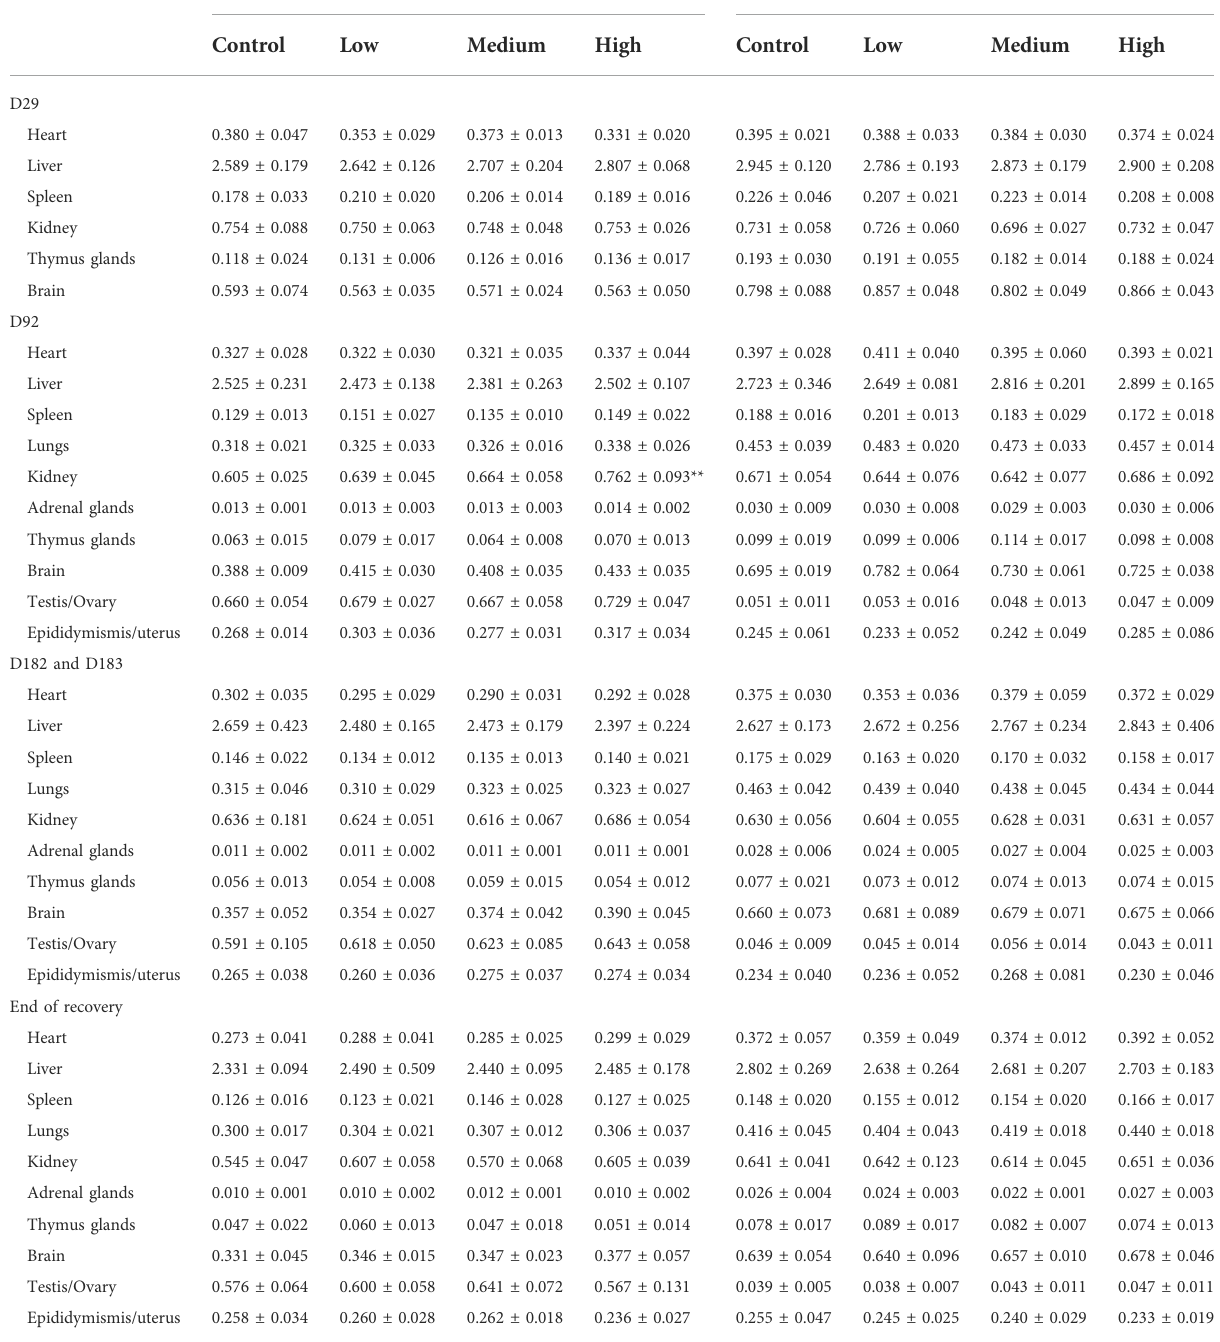
TABLE 4 Relative weight (organ weights/body weights)(%) in rats treated with